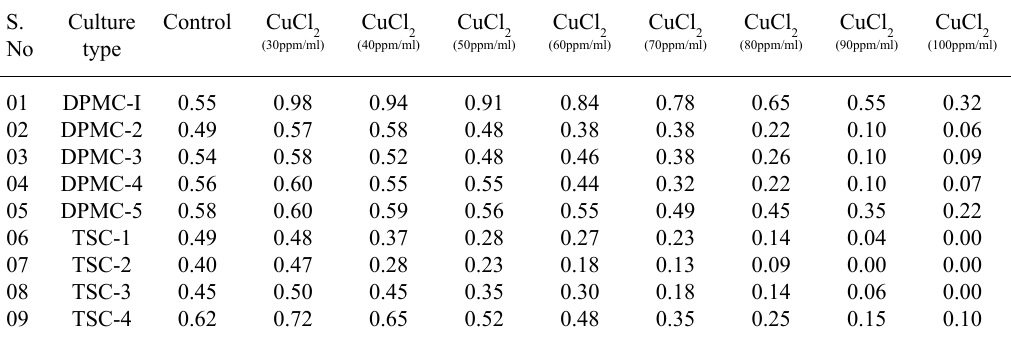
table 3. Effect of Copper on bacterial growth